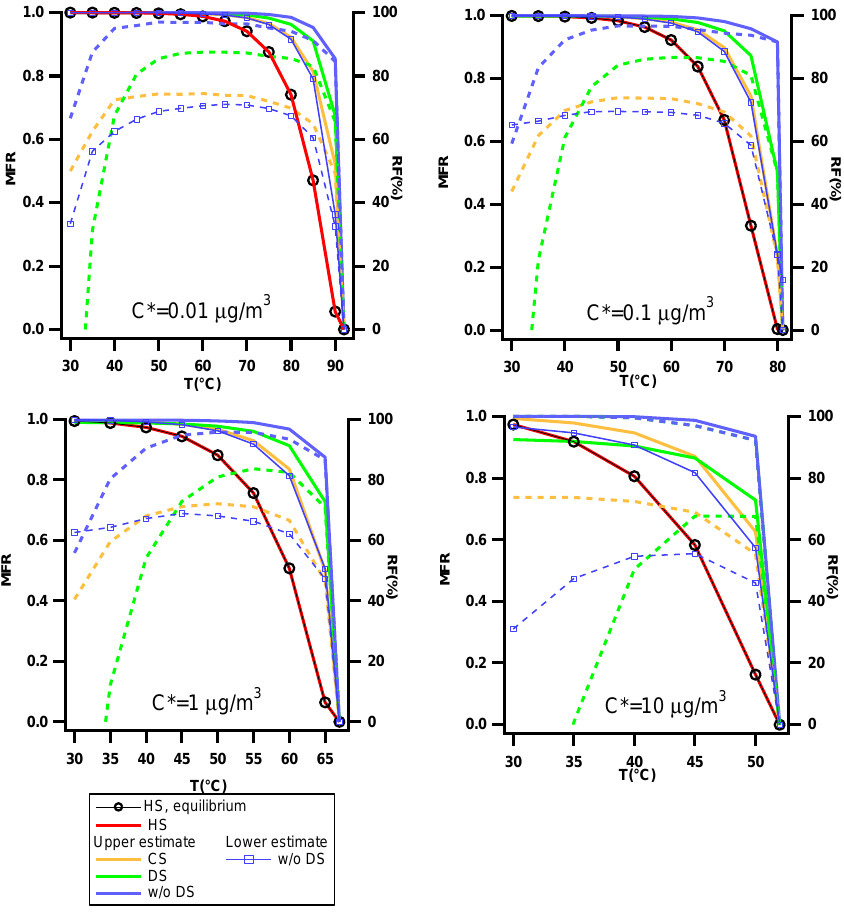
Fig. 4. Output thermograms and recondensation fraction for the heating section (HS), cooling section (CS), denuder section (DS) and equiv- alent configuration without denuder section (w/o DS) at different volatilities. Similar magnitude in the re-condensation fraction between the different volatility cases is obtained at equal MFR, due to the increase in volatility being counteracted by the low equilibrium satura- tion concentrations at low temperatures. The charcoal denuder is predicted to substantially influence thermograms only for C ∗ > 1µgm − 3 and temperatures below 45 ◦ C, by inducing particle evaporation. Baseline case: C OA =400µgm − 3 , d p =100nm, D i =5e–6cm 2 s − 1 and γ 0 =1.Upper estimate: upper estimate for re-condensation (no mass transfer to walls); lower estimate: lower estimate for re-condensation (equilibrium wall